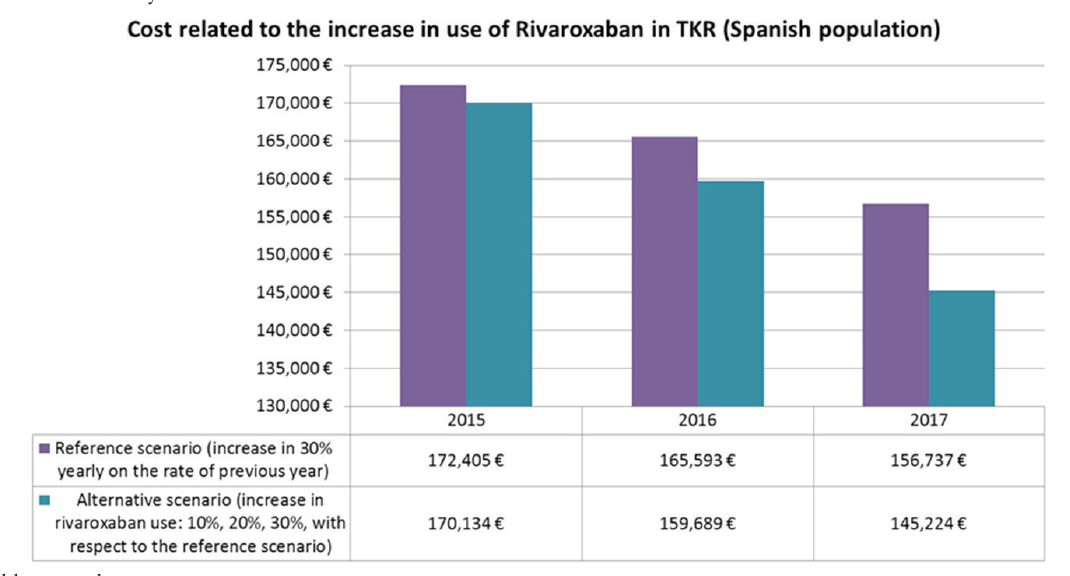
Figure 3. TKR Cohort Costs 2015-2017, Spanish population; TKR Cohort Total Costs 2015-2017 in the